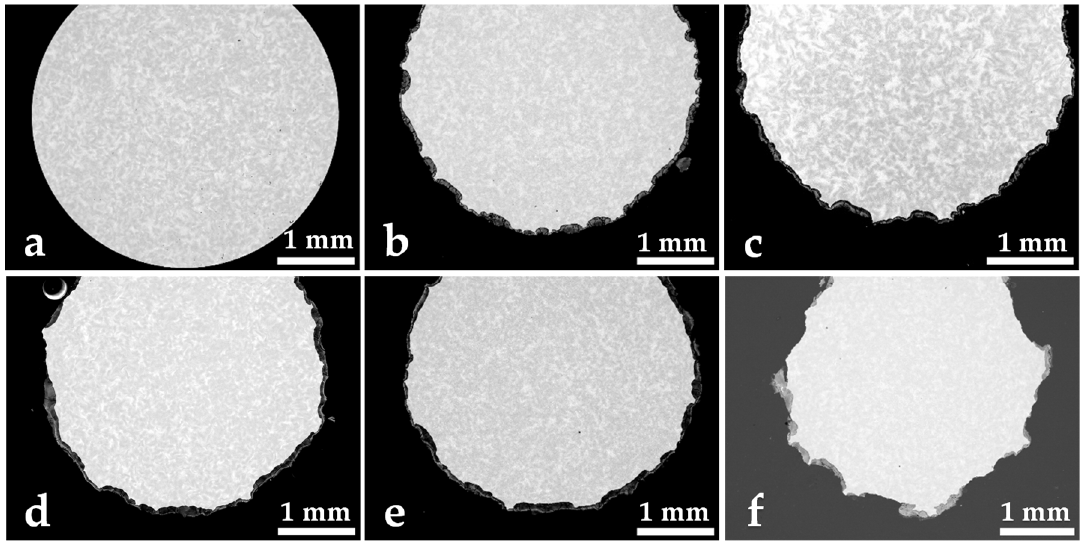
Figure 2. SEM BSE images of cross sections (perpendicular to the axis of the specimen) showing specimen before corrosion ( a ) and after 7 days ( b ), 14 days ( c ), 21 days ( d ), 28 days ( e ), or 70 days ( f ) of immersion time.